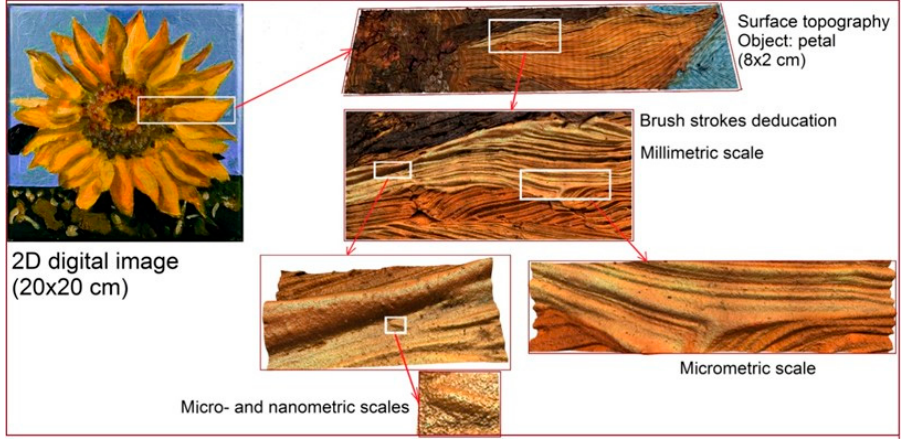
Figure 2. Schematic summary of scales contained in the studied artwork.